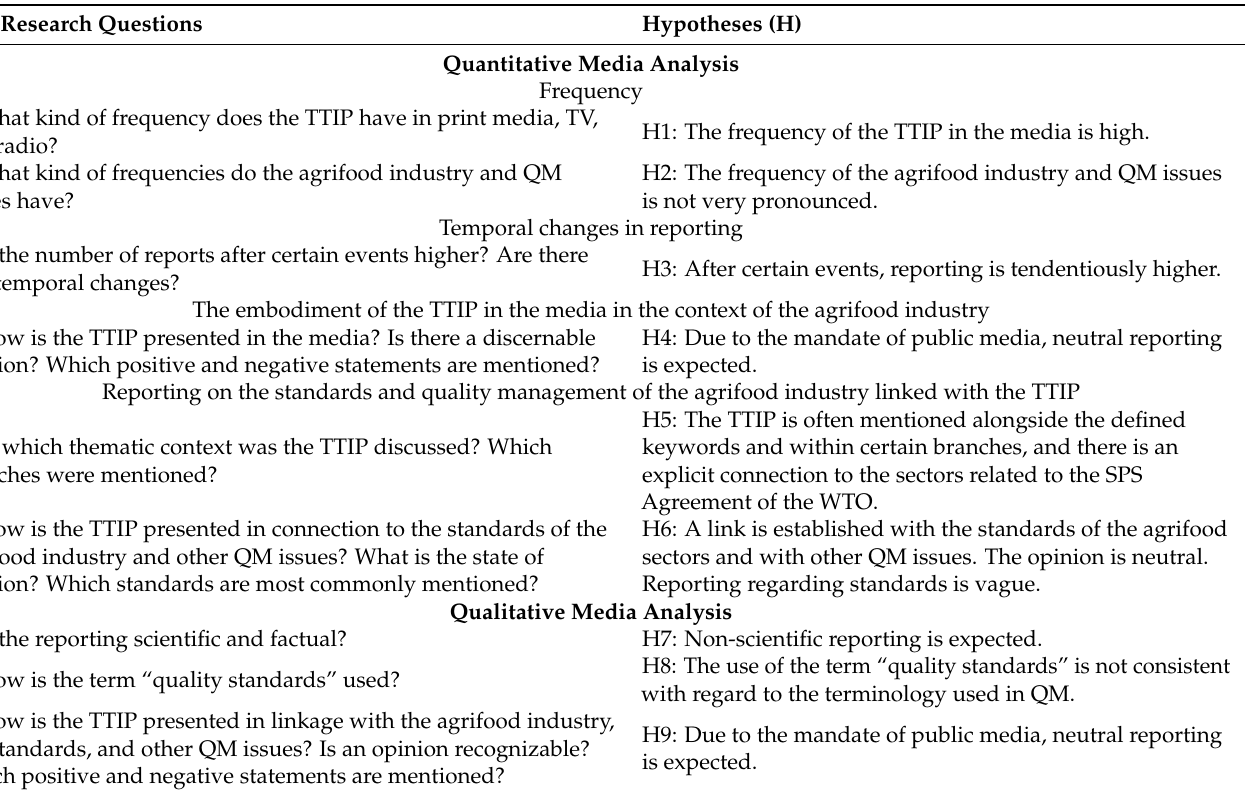
Table 1. Sub-research questions with the corresponding hypotheses of quantitative and qualitative media